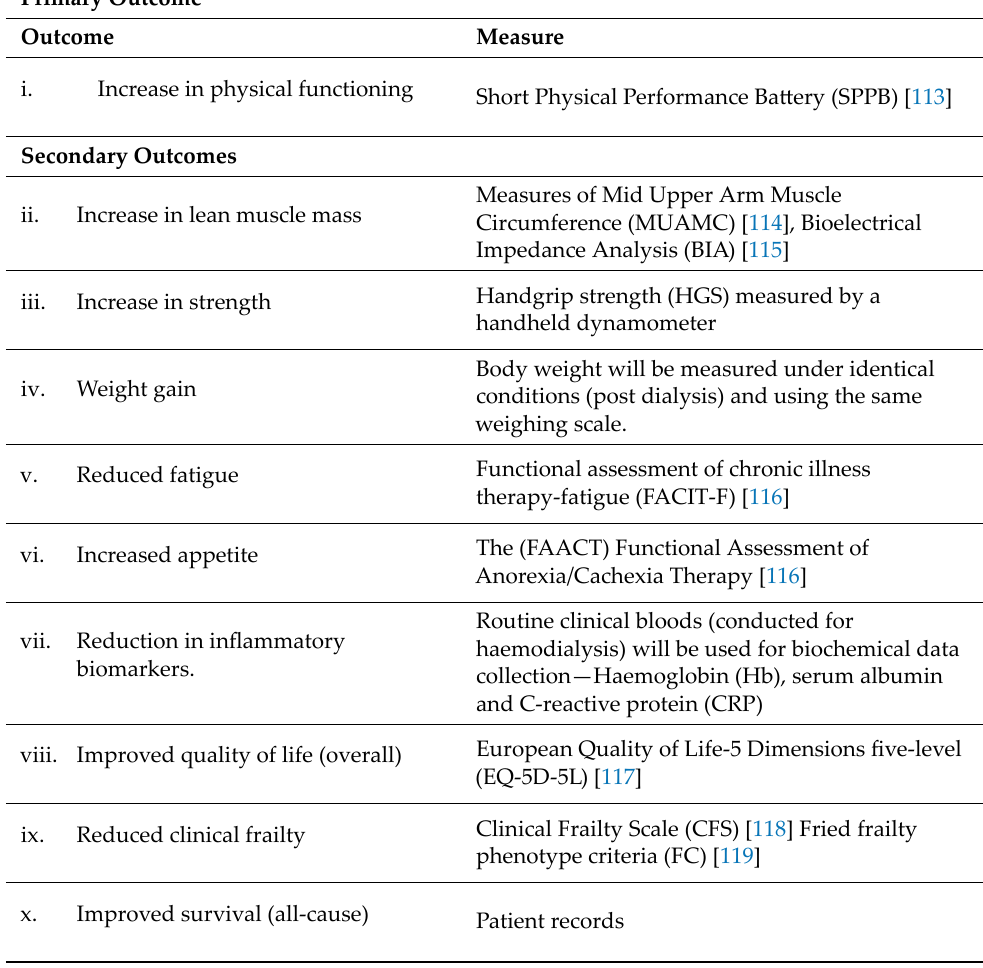
Table 3. Long‑term outcomes and